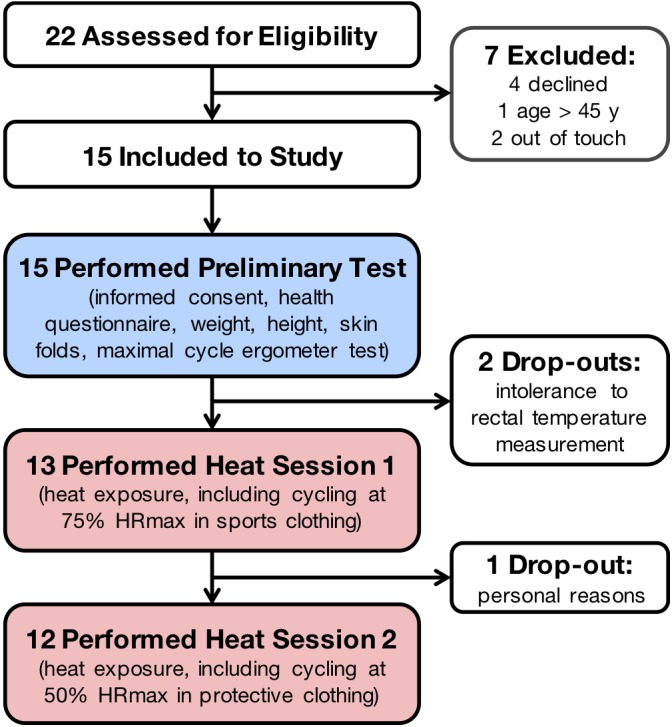
Flow diagram of the participants. HR max, maximal heart rate.